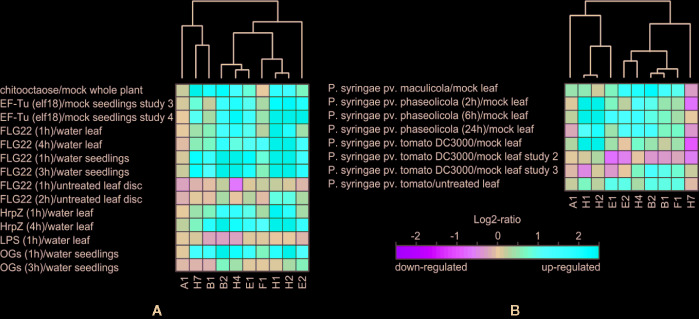

(A) Hierarchical clustering of biotic stress-responsive EXO70 isoforms upon elicitor treatment. (B) Hierarchical clustering of EXO70 isoforms according to expression levels upon bacterial treatments. For gene terminology see
Figure 1
.